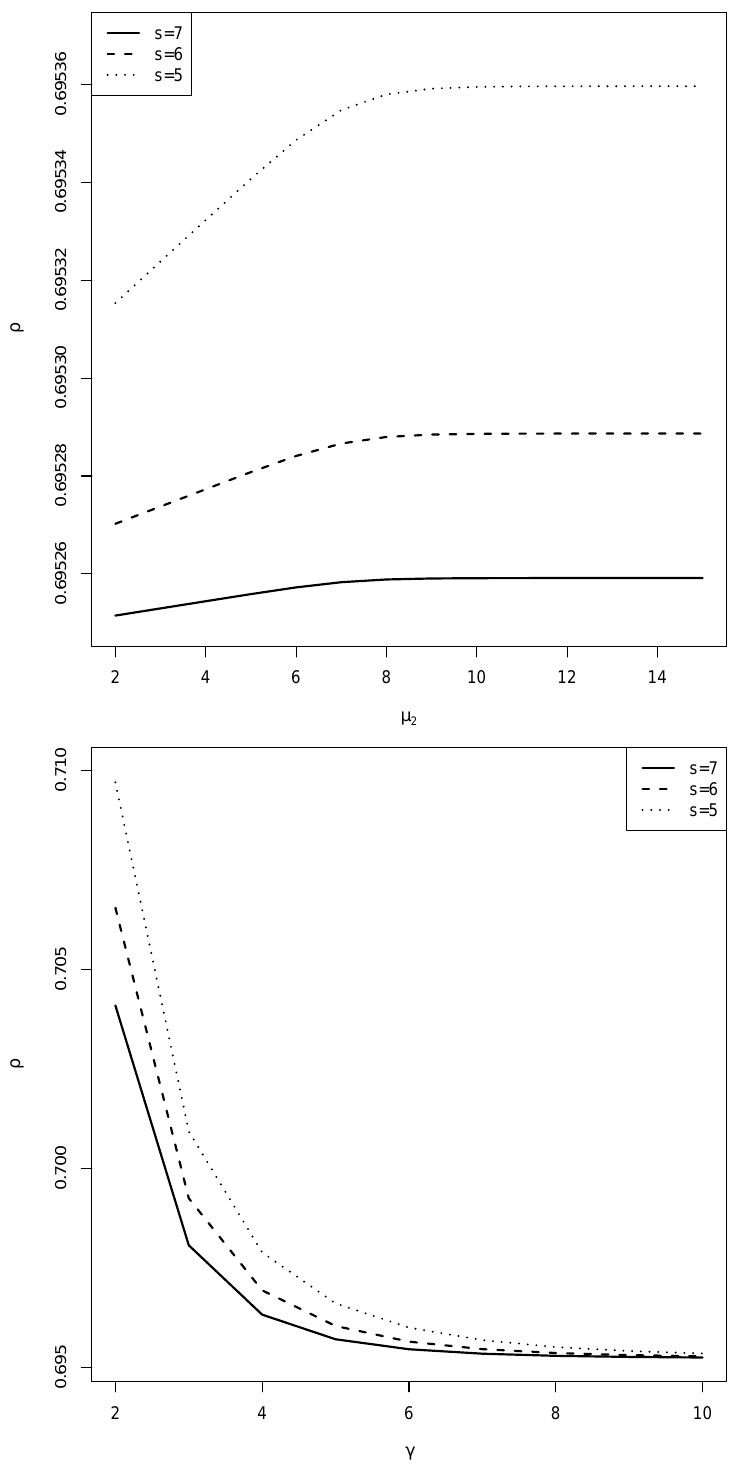
Figure 2. Dependency of ρ on µ 2 ∈ [ 2,15 ] ( top , fixed γ = 10) and on on γ ∈ [ 2,10 ] ( bottom , fixed µ 2 = 15) for s = 5,6,7 and other parameters fixed: S = 100, l 2 = 15, µ 1 = 7, MMAP arrival process parameters given in